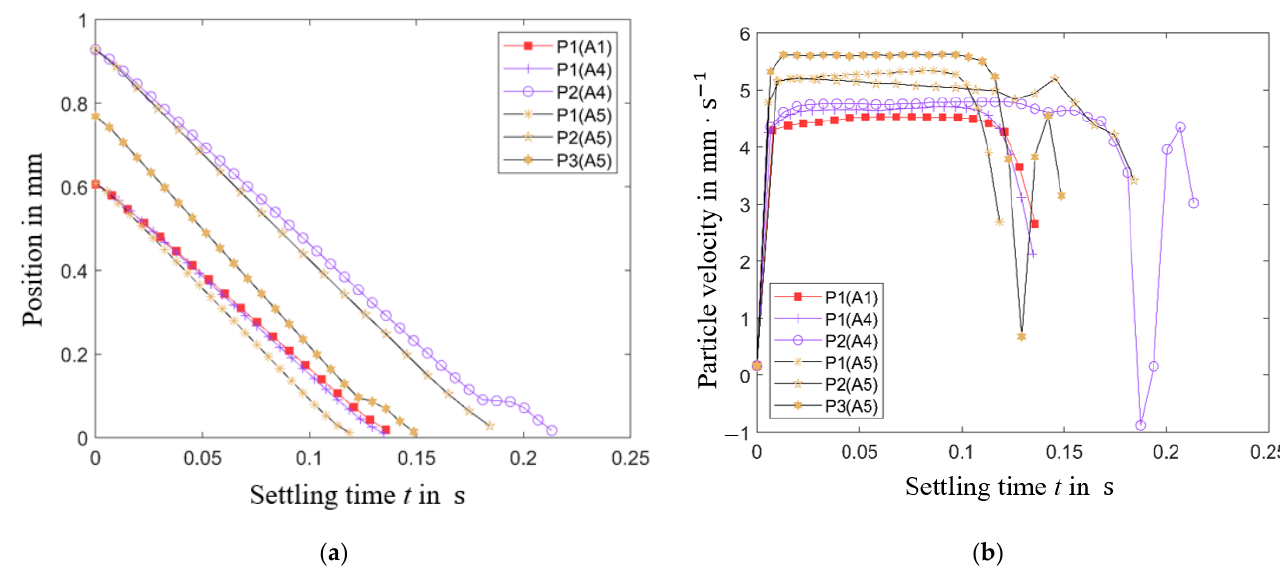
Figure 17. Influence of the neighboring particles following one another on the settling behavior: ( a ) vertical distance of the particle to the bottom wall over settling time, ( b ) particle vertical velocity component (in z-direction) over time.